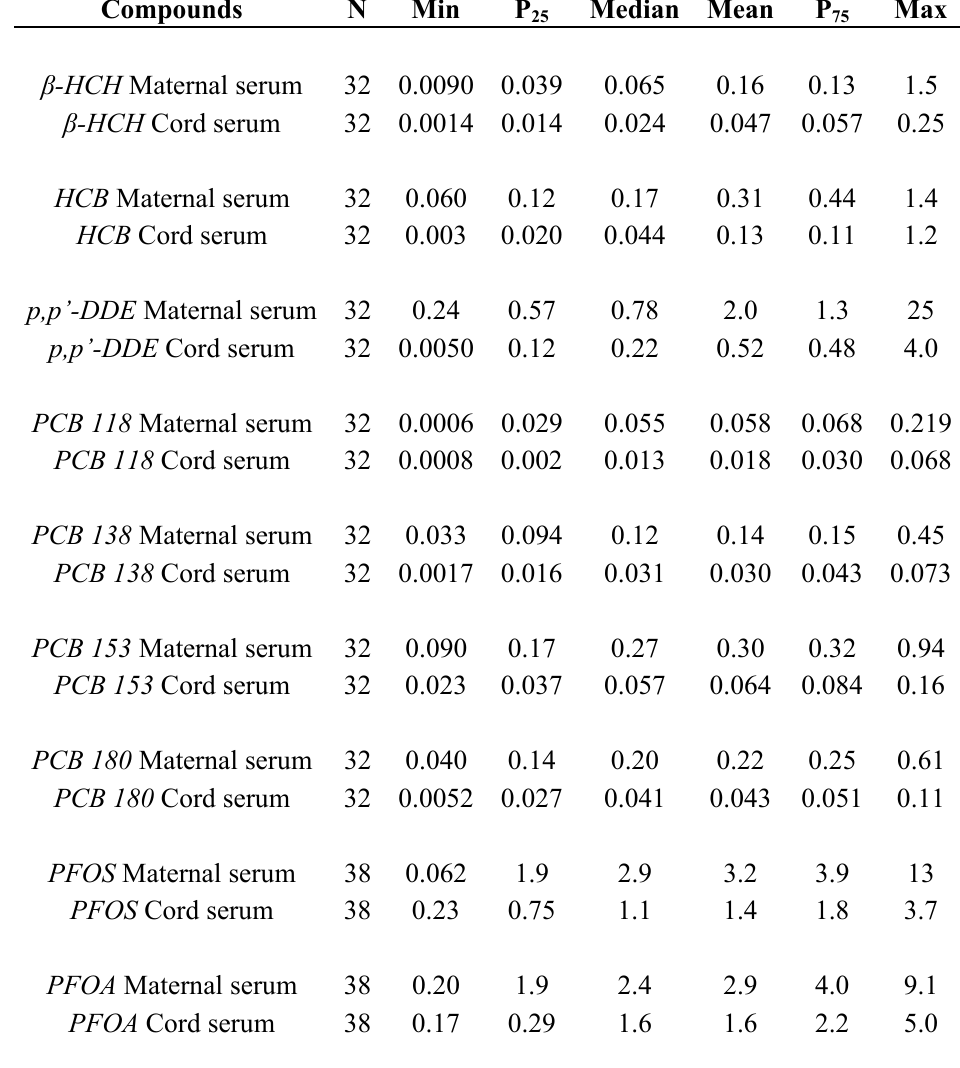
Table 2. Serum concentrations (ng/g, fresh weight) of organochlorinated pesticides ( β -HCH, HCB and DDE), four congeners of polychlorobiphenyls (PCBs) and perfluorinated compounds (PFCs) in maternal and cord samples. Values rounded off to two figures. Concentrations <LOQ included in the